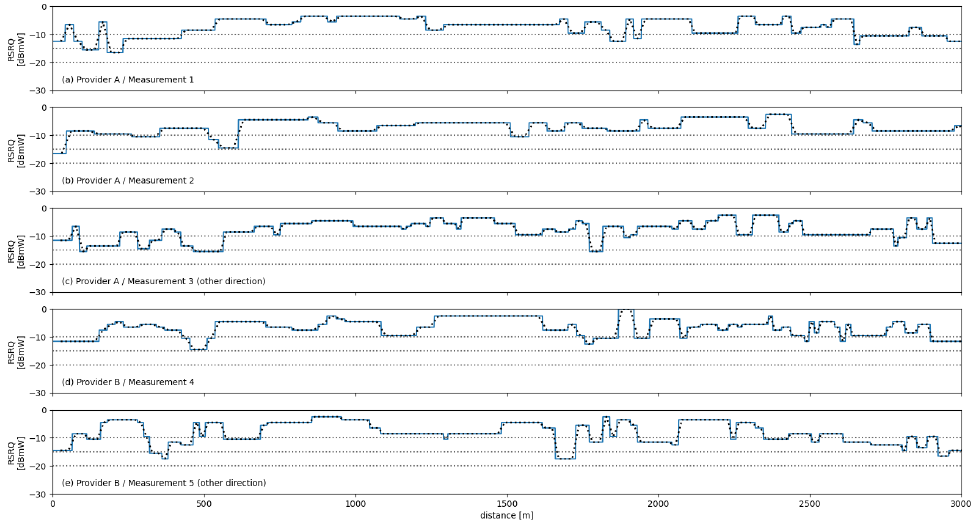
Figure 11. RSRQ as a function of distance (solid lines: raw data; dots: resampled, interpolated data). Gray, dotted horizontal lines indicate ranges according to Table